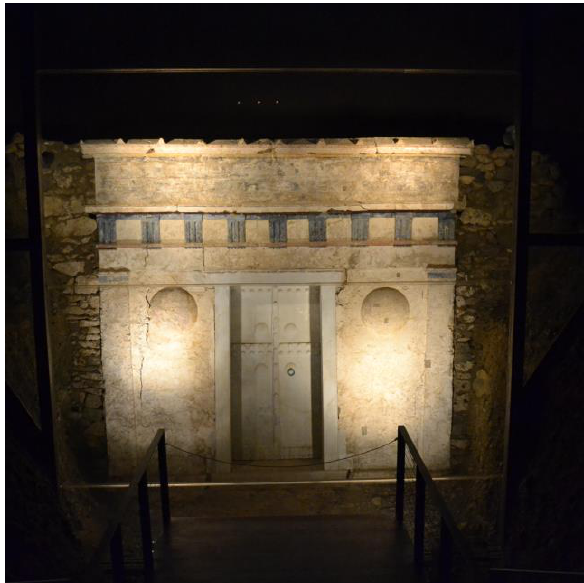
Figure 3. View of the Tomb of Alexander IV. Photos by the authors.